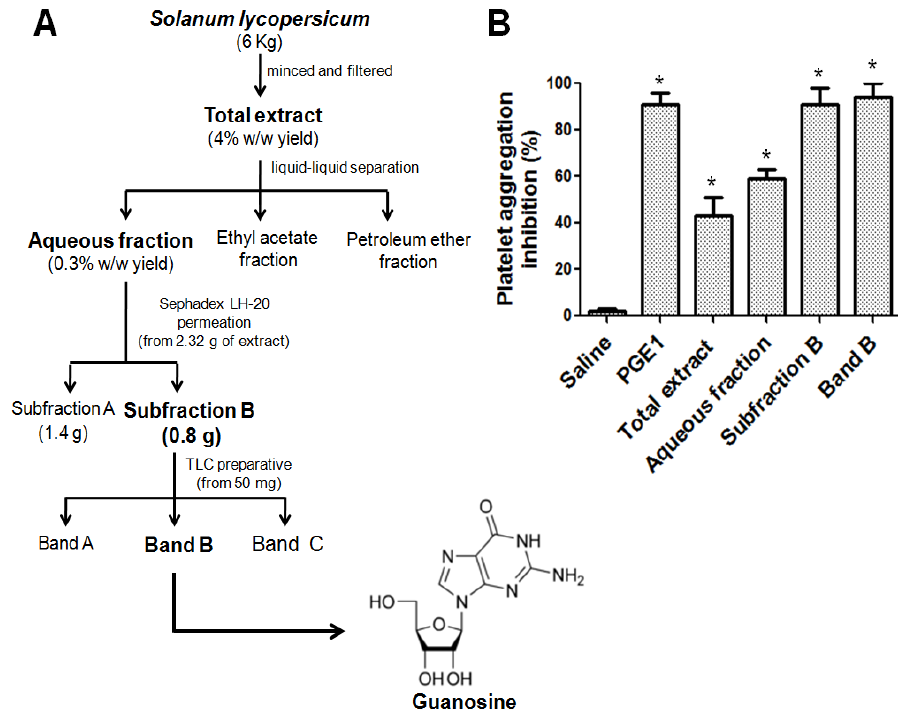
Figure 1. Scheme of the extraction and bioguided fractionation of S. lycopersicum